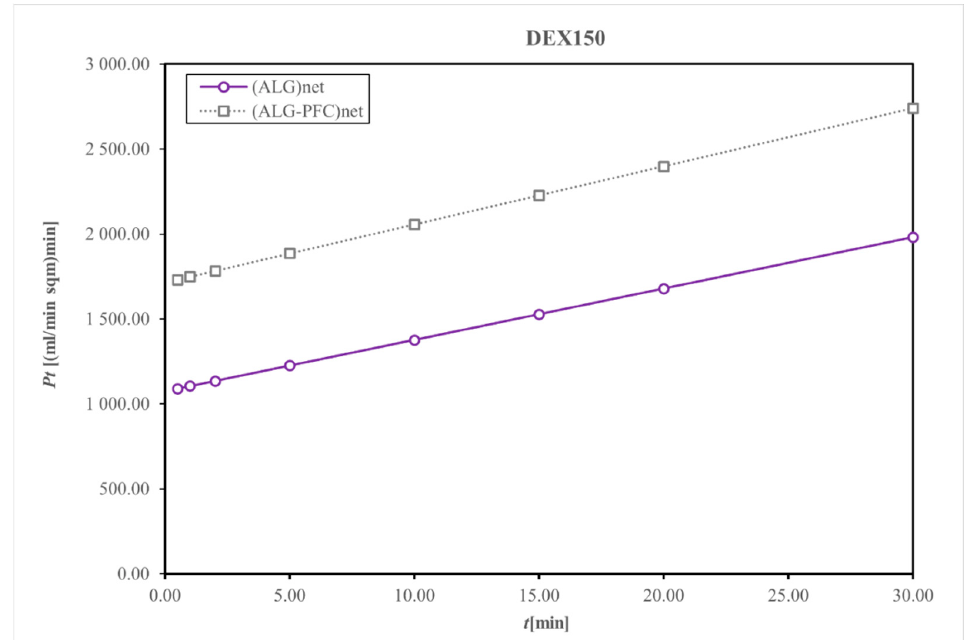
Figure 8. Representative membrane permeability and time product during particular time intervals permeation for Dextran 150. Key to symbols: (ALG-PFC) net —alginate–perfluorooctyl cross-linked; (ALG) net —alginate cross-linked.